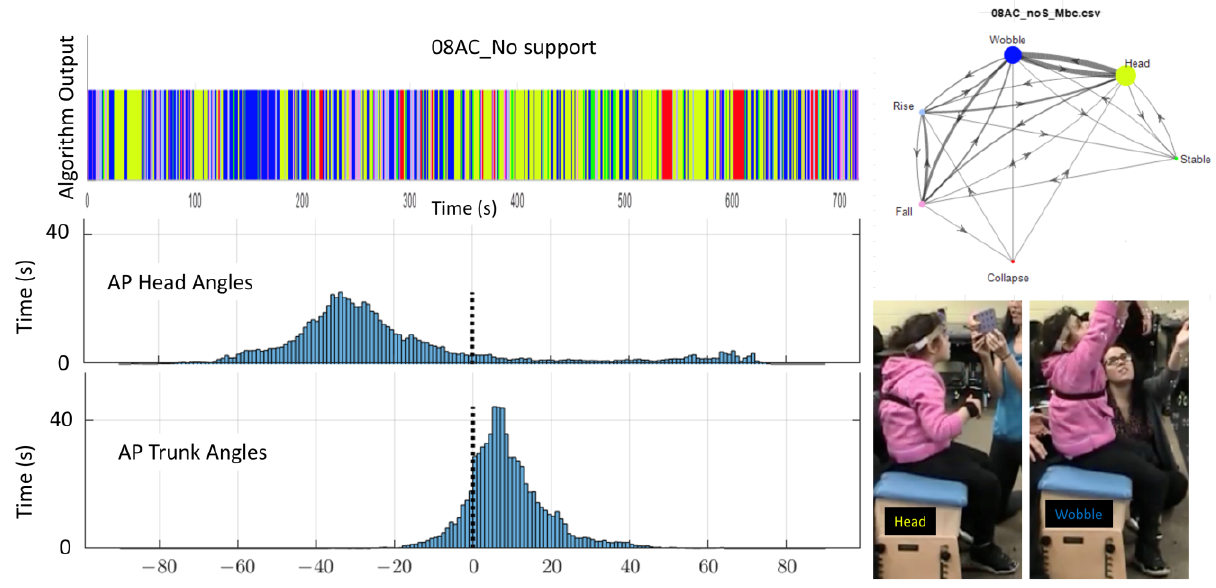
Figure 12. Example of algorithm output (colored bar) for the full 12-min, and AP histograms (bottom) and two images (right) showing AP alignment for 08AC during the no support condition. The histogram is qualitatively consistent with Wobble and Head. Markov model (upper right) indicates stages (colored circles), amount of time spent in each stage (relative size of circles), transitions between states (lines with arrows), and frequency of transitions coming from each node (line thickness).